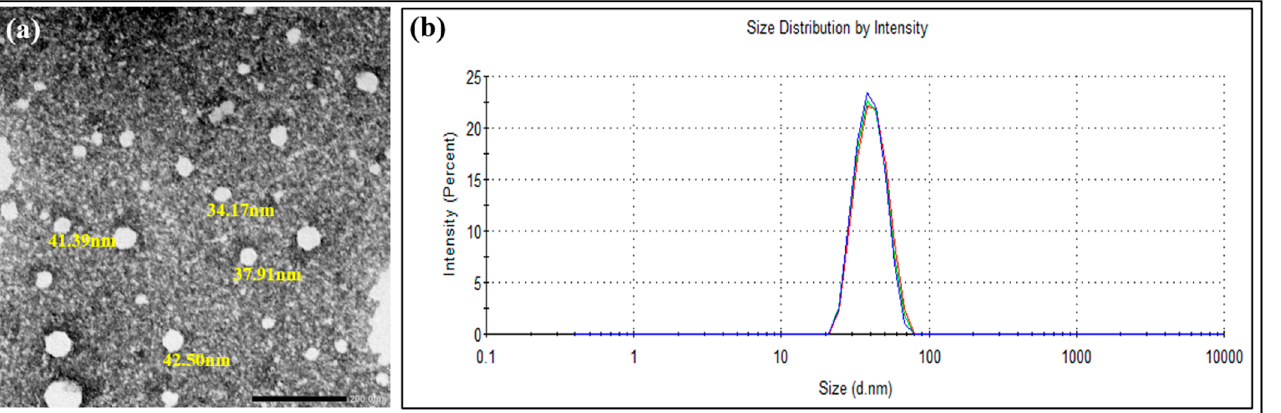
Figure 1. ( a ) TEM image of CsA-loaded lipid nanocapsules (LNCs) × 30,000. The scale bar represents 200 nm. ( b ) Size distribution by intensity curve of CsA-loaded LNC dispersion.